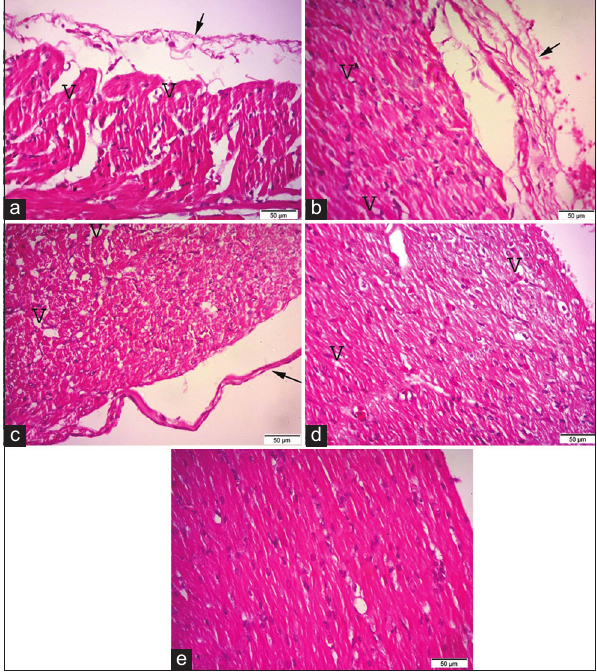
Figure-1: Photomicrographs of hematoxylin and eosin (H&E) stained sections of the liver, (a) the liver of G1 (broilers supplemented with 0.5 g/L Bacillus subtilis ) showing adhesive perihepatitis (arrow), mononuclear cell infiltration (arrowhead), vaculation of hepatocytes cytoplasm (V) with mild hemorrhage (H). (b) The liver of G2 (broilers supplemented with 1.0* g/L B. subtilis ). (c) The liver of G3 (broilers supplemented with 1.5 g/L